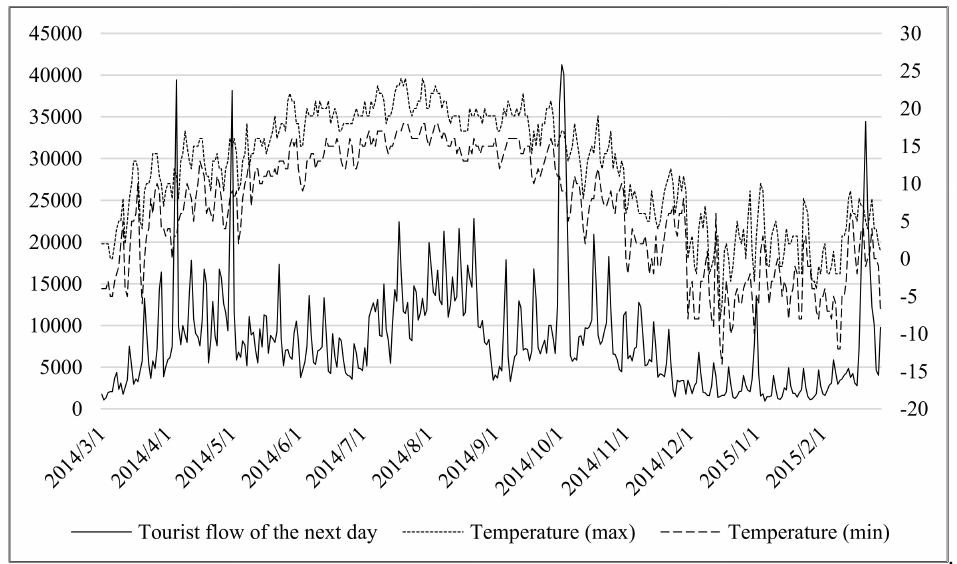
Figure 3. Daily tourist flow, along with the maximum and minimum daily temperatures, during March 2014 to February